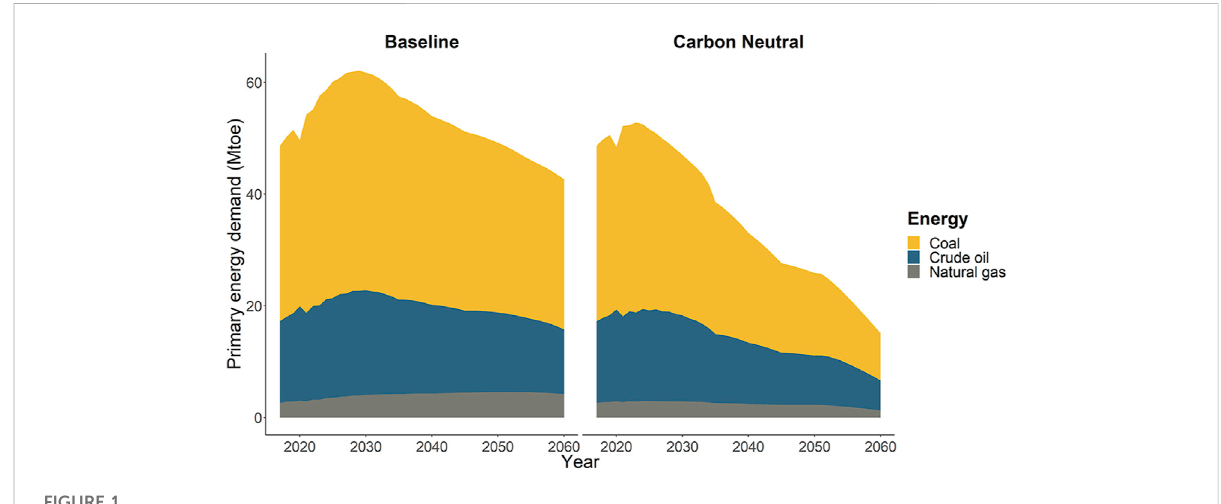
FIGURE 1 Primary fossil fuel demand in baseline and carbon neutral scenarios by